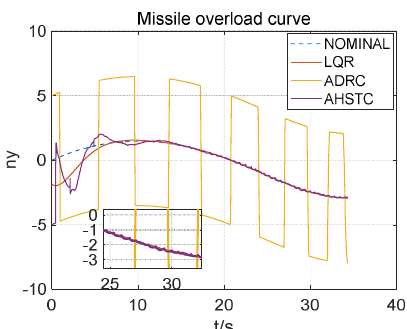
Figure 11. Control tracking curve.